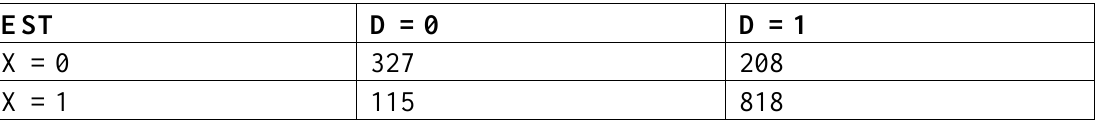
Table 2. Exercise stress test and heart disease.